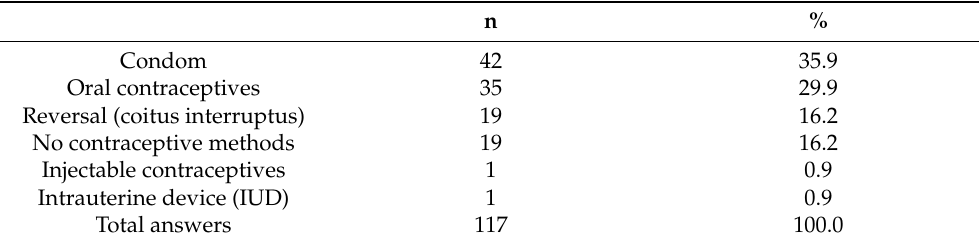
Table 3. Contraception